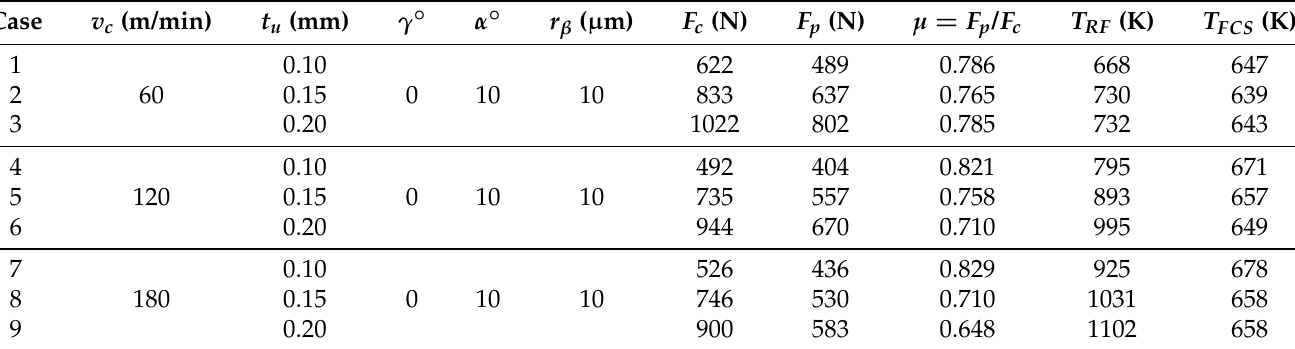
Table 2. Cutting experiments data for AISI 1045.